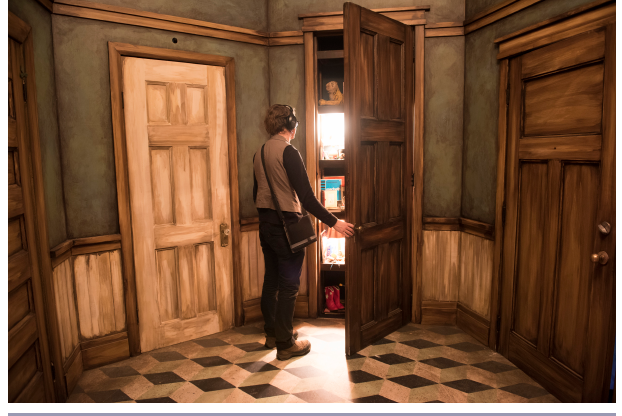
Fig. 6 . The literary room. (Photo by Emily Cooper.)